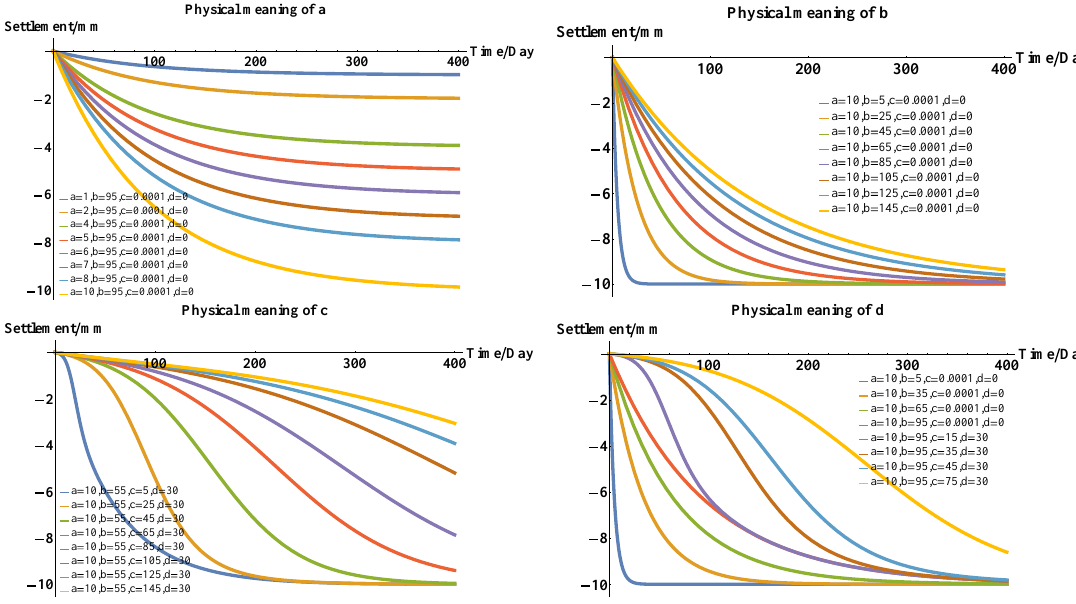
Figure 3. Descriptive ability of this model.